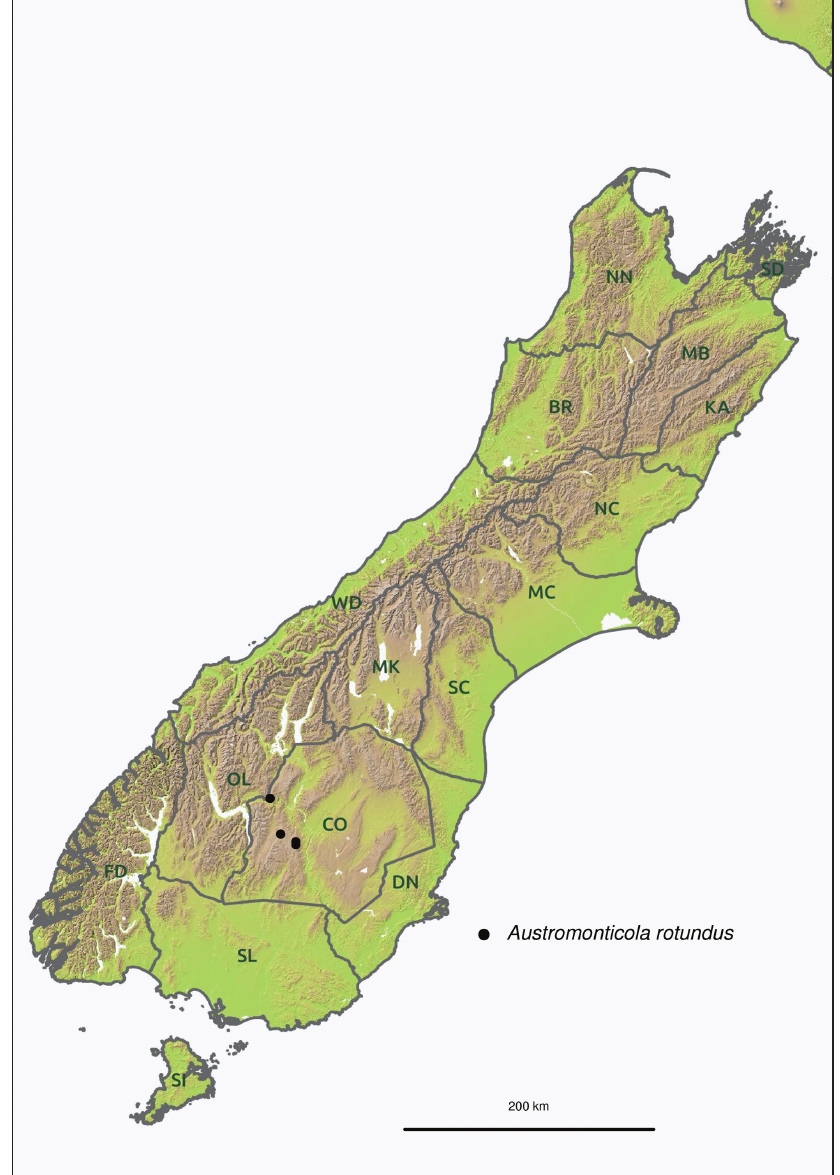
Figure 117. Distribution of Austromonticola rotundus